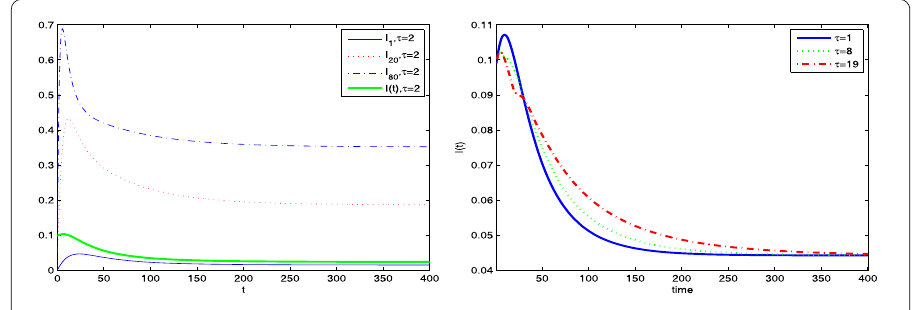
Figure 2 Dynamical behaviors of system (4) with R 0 = 1.4596.